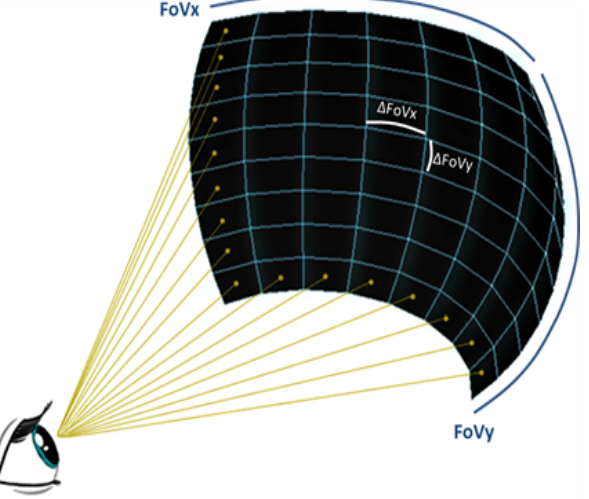
Figure 5. Discretization of the 3D space according to rays generated from the viewpoint of interest.